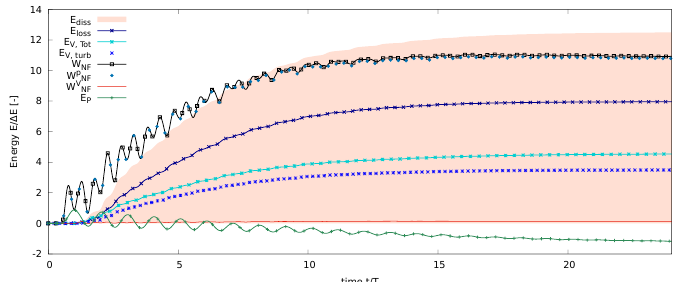
Figure 28. Energy distribution for oil 3D simulation at N 50 resolution.